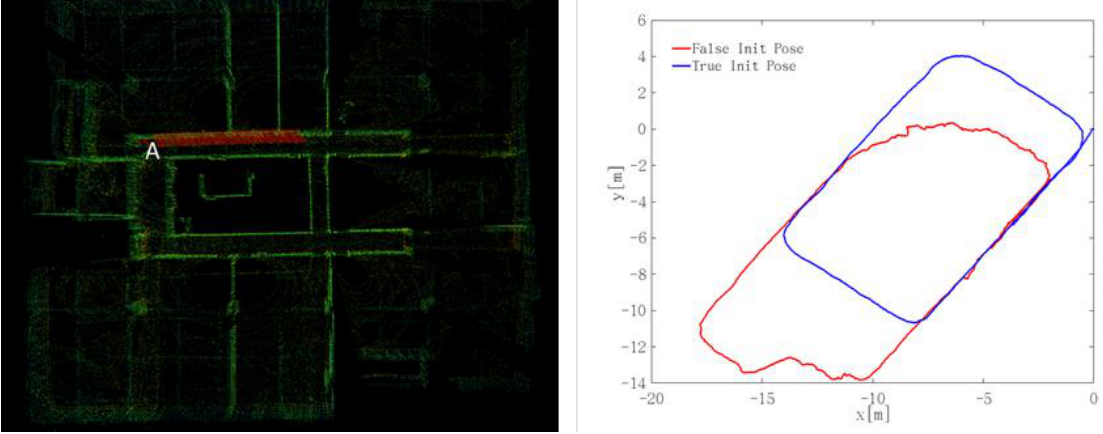
Figure 18. The influence of the initial true coordinate (0, 0, 0) on the localization.